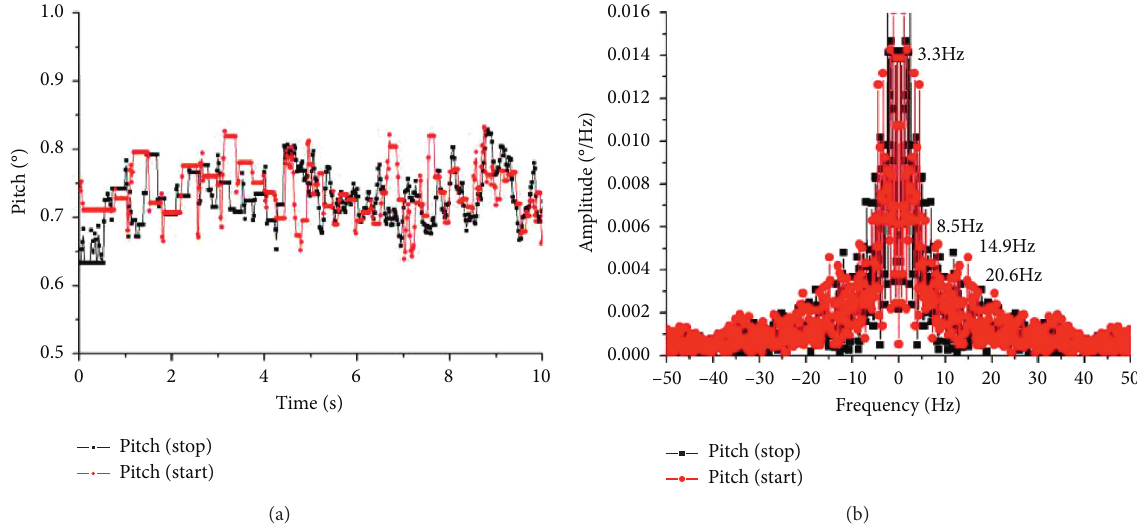
Figure 6: (a) Pitch angle change when the engine starts and stops. (b) Pitch spectrum change when the engine starts and stops.